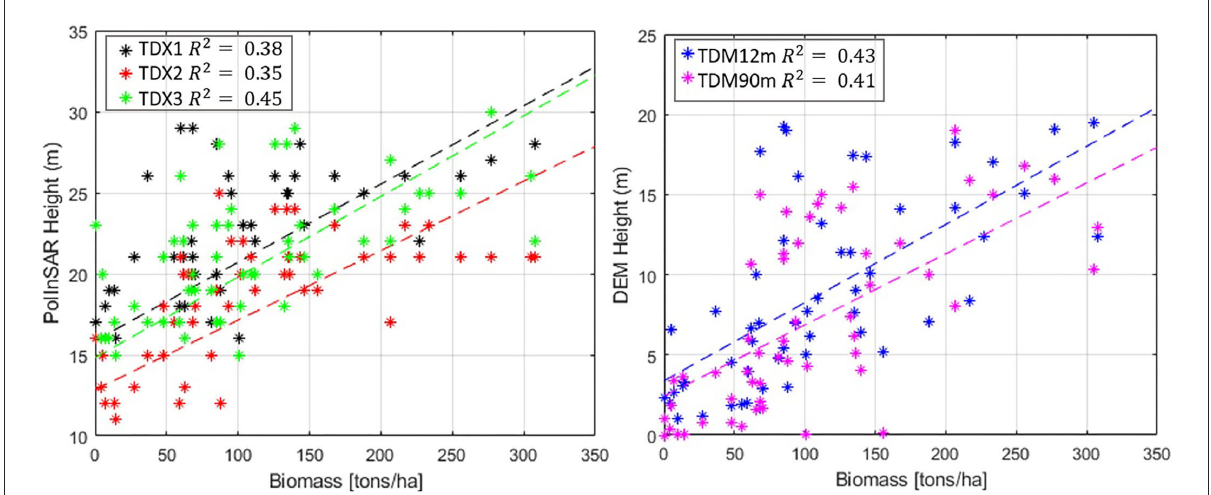
FIGURE6 Relation between PolInSAR height (left) and DEM estimated height (right) as a function of AGB. The PolInSAR heights are estimated from three TanDEM-X acquisitions and DEM estimated heights are from 12 and 90 m TanDEM-X Global DEM and interpolated DTM. Dashed lines are the least-squares estimated best-fit